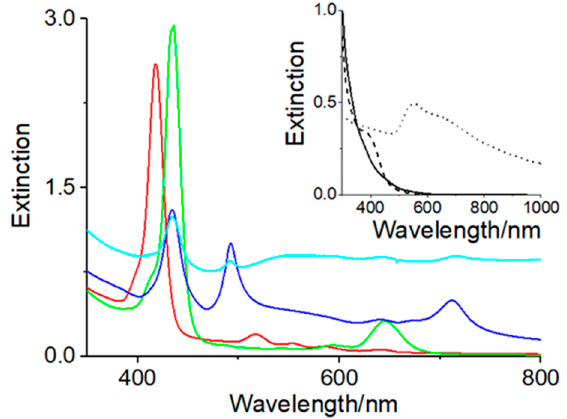
Figure 1. UV–vis spectra of tetrakis(4-sulfonatophenyl)porphyrin (TPPS)–Au 10 in aqueous solution (red line): instantaneously upon HCl addition (pH 2) (green line), after 1 h (blue line), after 24 h (cyano line). The inset shows the crude Au 10 NCs for the same experimental conditions in aqueous solution (black full line) upon HCl addition (pH 2) instantaneously (black dashed line) and after 24 h (black dotted line). Experimental conditions: [Au 10 ] = 125 µ M, [TPPS] = 5 µ M.